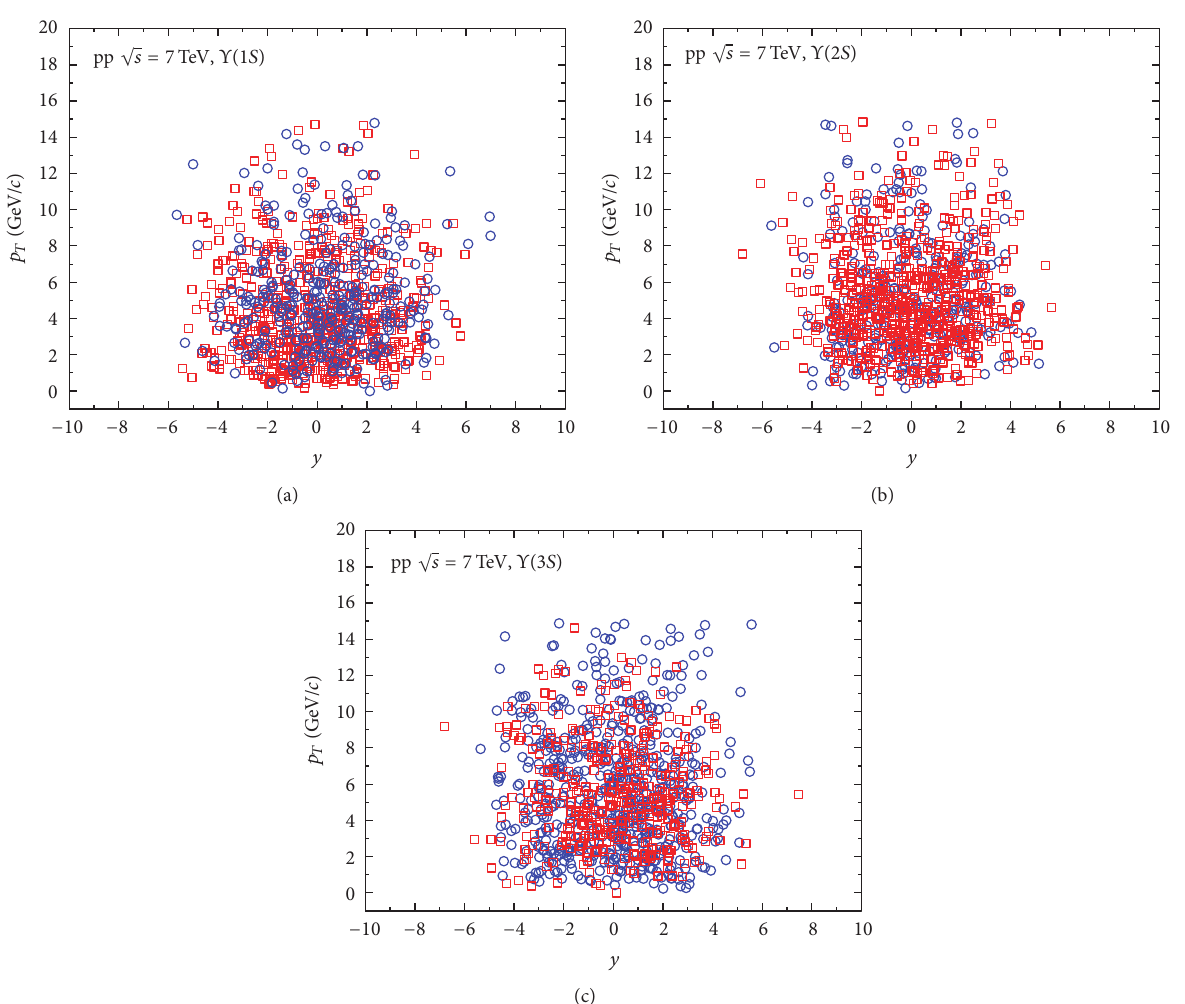
Figure 9: Same as Figure 3, but showing the results for (a) Υ(1𝑆) , (b) Υ(2𝑆) , and (c) Υ(3𝑆) mesons produced in pp collisions at √𝑠 = 7 TeV.